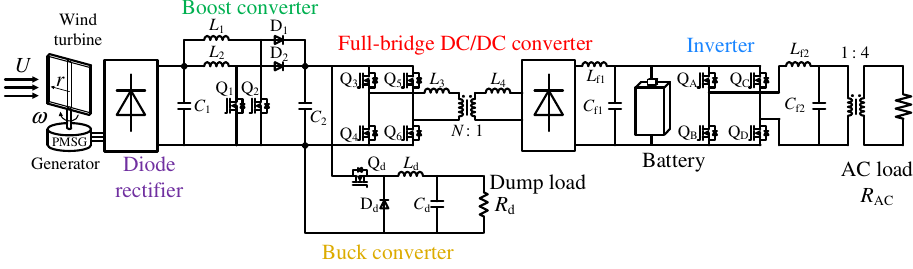
Figure 1. Previously proposed standalone WPGS [8].